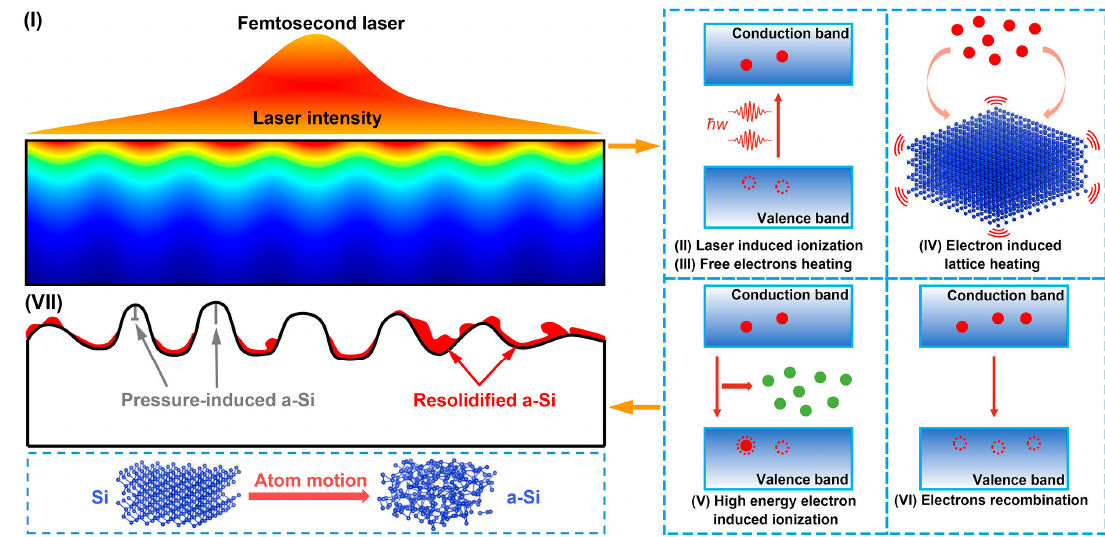
Figure 8. Scheme of electron and lattice dynamics interactions during LIPSS formation.